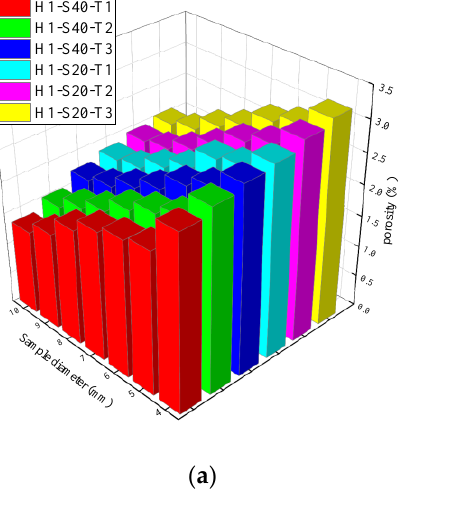
Figure 9. Porosities of TRC; ( a ) H1; ( b ) H2.